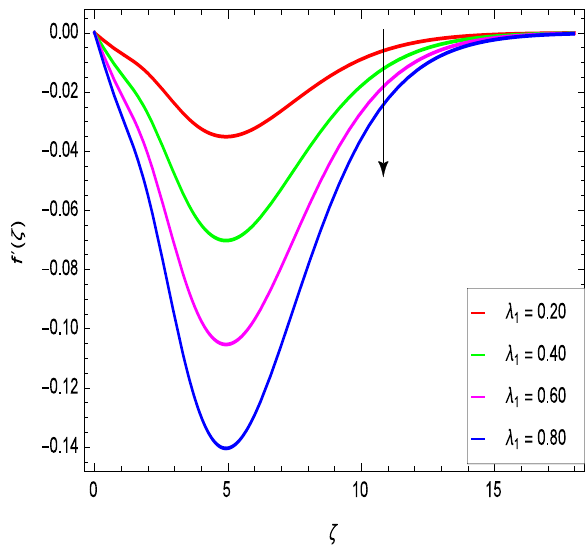
Figure 2. f ′ (ζ) in terms of (cid:31) 1 .